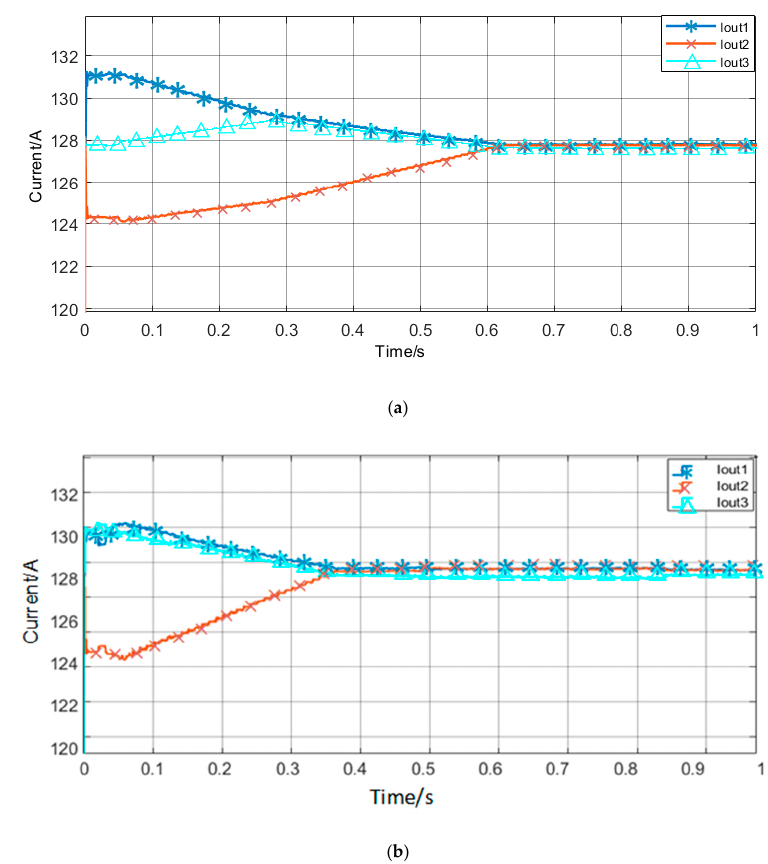
Figure 9. Output current balancing control performance with the resonant inductance of ( a ) L r 1 = L rd , L r 2 = 0.9 L rd , L r 3 = 0.95 L rd and ( b ) L r 1 = 1.05 L rd , L r 2 = 0.9 L rd , L r 3 = 0.95 L rd